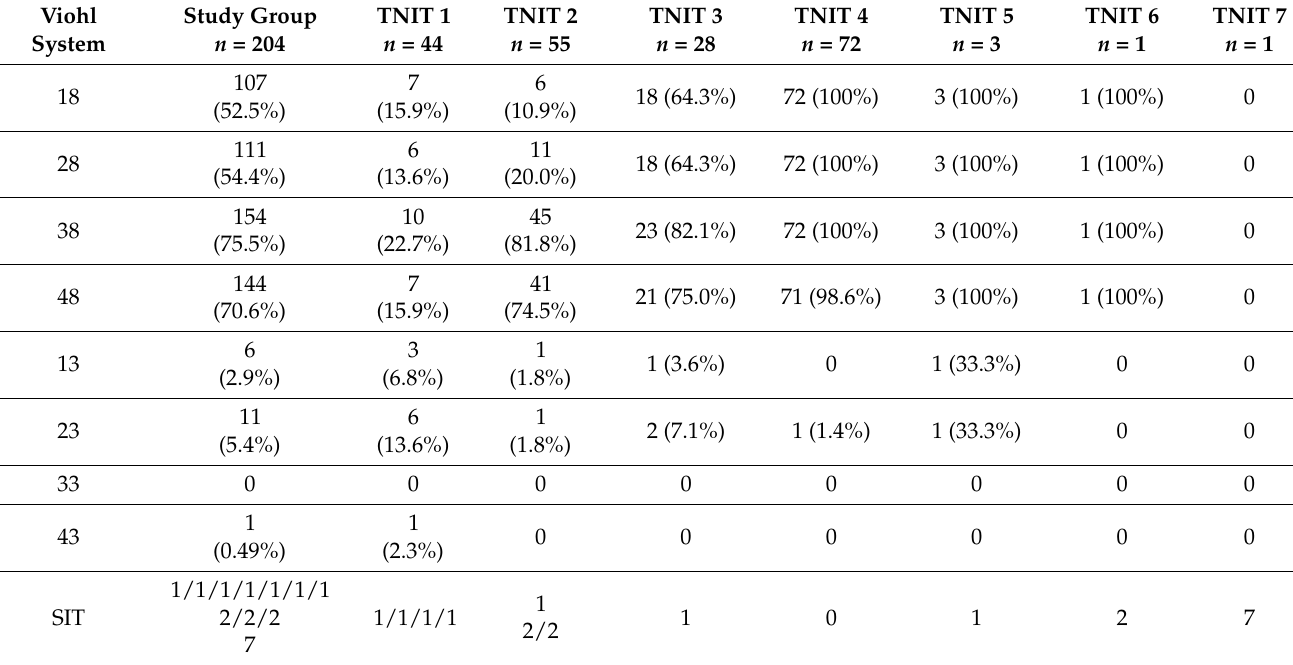
Table 3. Proportion of different tooth types (according to the Viohl system) depending on the number of impacted teeth in study group patients.